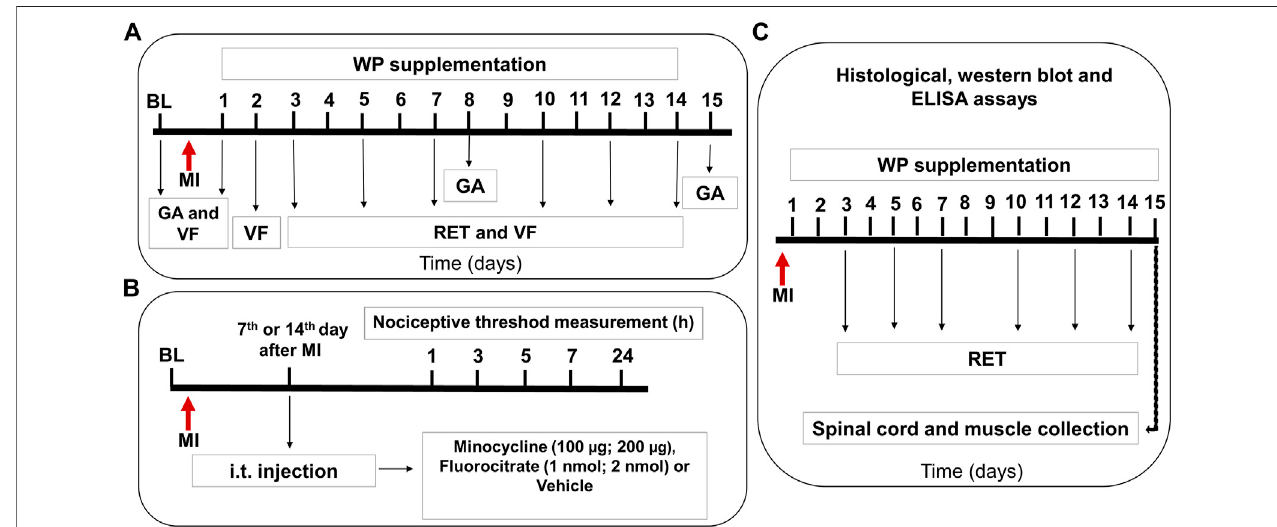
FIGURE 1 | Representative scheme of experimental protocols for the evaluation of muscle injury – induced nociception. Panel (A) shows that after evaluation of the baseline (BL) for gait (GA) or nociceptive threshold by the digital von Frey test (VF), the muscle injury (MI) was induced. After that, the rats were subjected to daily supplementation with whey protein (WP) and/or resistance exercise training (RET, 3 days a week for 2 weeks). A new measurement of the nociceptive threshold was performed after 1, 2, 3, 5, 7, 10, 12, and 14 days, and a new GA analysis was performed after 1, 8, and 15 days. Panel (B) shows the evaluation of involvement of the spinal microglia and astrocytes in the muscle injury – induced nociception. After BL evaluation, the animals were subjected to MI, and after 7- and 14-days of minocycline, fl uorocitrateorvehiclewasintrathecallyinjected.Panel (C) showsthatafterMI,theratsunderwentWPsupplementationand/orRET,andafter15 days,they were euthanized to collect the spinal cord and muscles that were later used for histological and Western blot analysis.